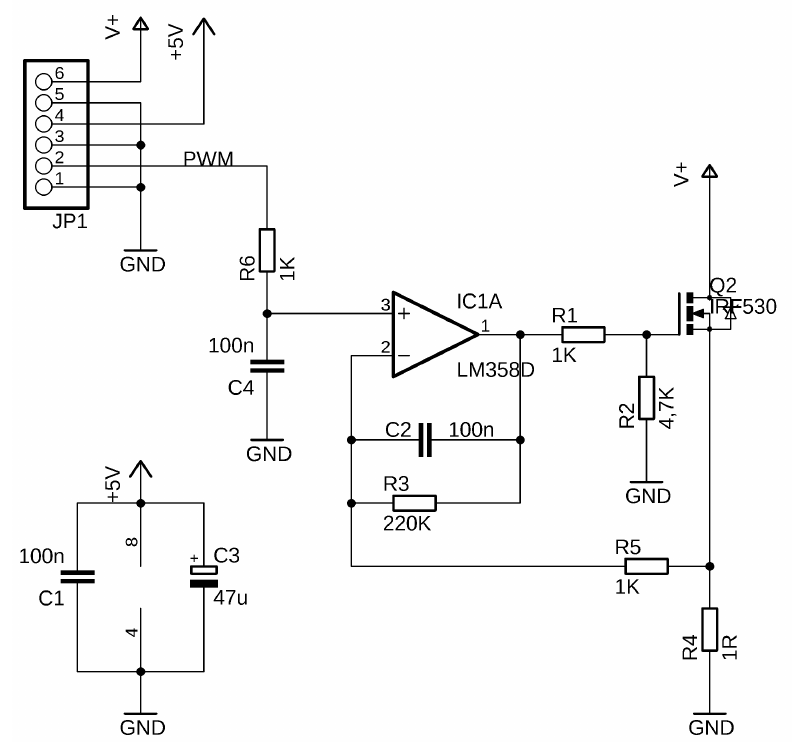
Figure 11. Electronic load